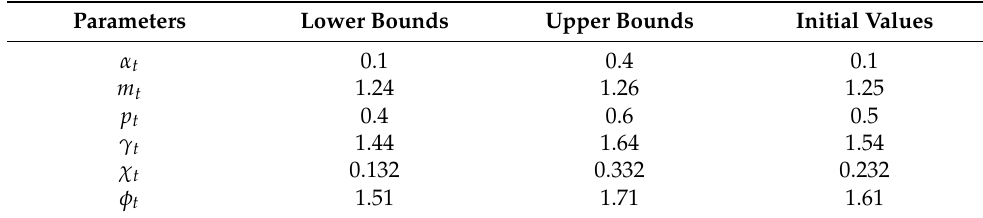
Table 1. The bounds of tuning factors.